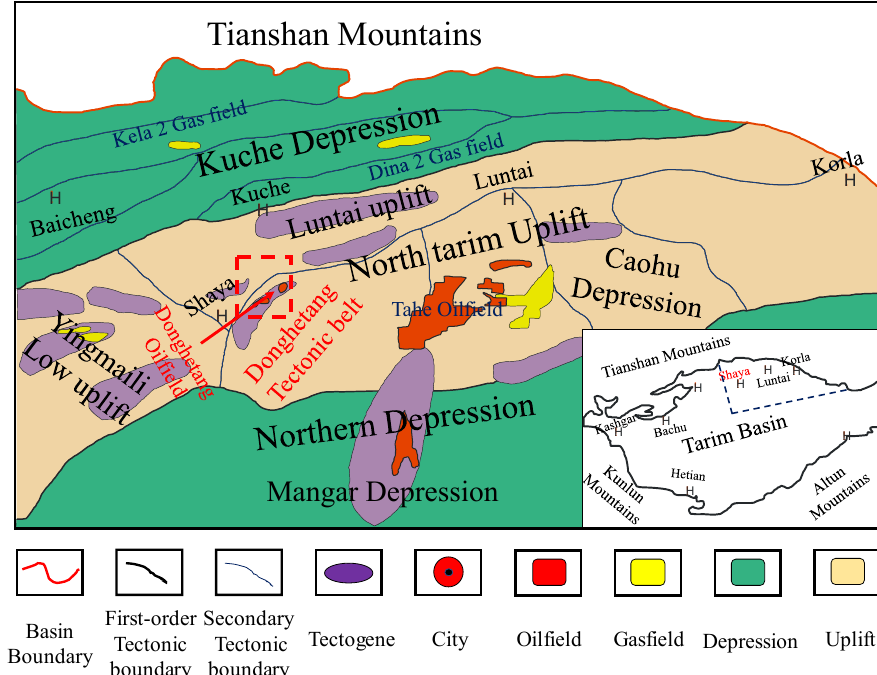
Figure 1. Regional location and tectonic features of the Tarim Basin [5]. The Donghe 23 trap is located in the Donghetang fault zone on the northwest margin of the Lunnan low salient in the Tarim Basin. The Donghetang fault structural zone is situated in the Tabei uplift (Figure 1). The north is the Kuche oil ‐ bearing sag, and the south is the hydrocarbon generation center of the marine hydrocarbon source rocks in the Man ‐ gar sag. Well DH 231 is an appraisal well located in the Donghe 23 trap. To date, only one well has been drilled within the trap. The appraisal well was originally designed to pene ‐ trate the JIII formation and to explore the distribution of hydrocarbons in the JIV for ‐ mation (Figure 2). Reservoir heterogeneity is strong, and local low ‐ permeability reservoirs have developed. The target layer of Well DH231 is generally the oil permeable layer with medium and low porosities.